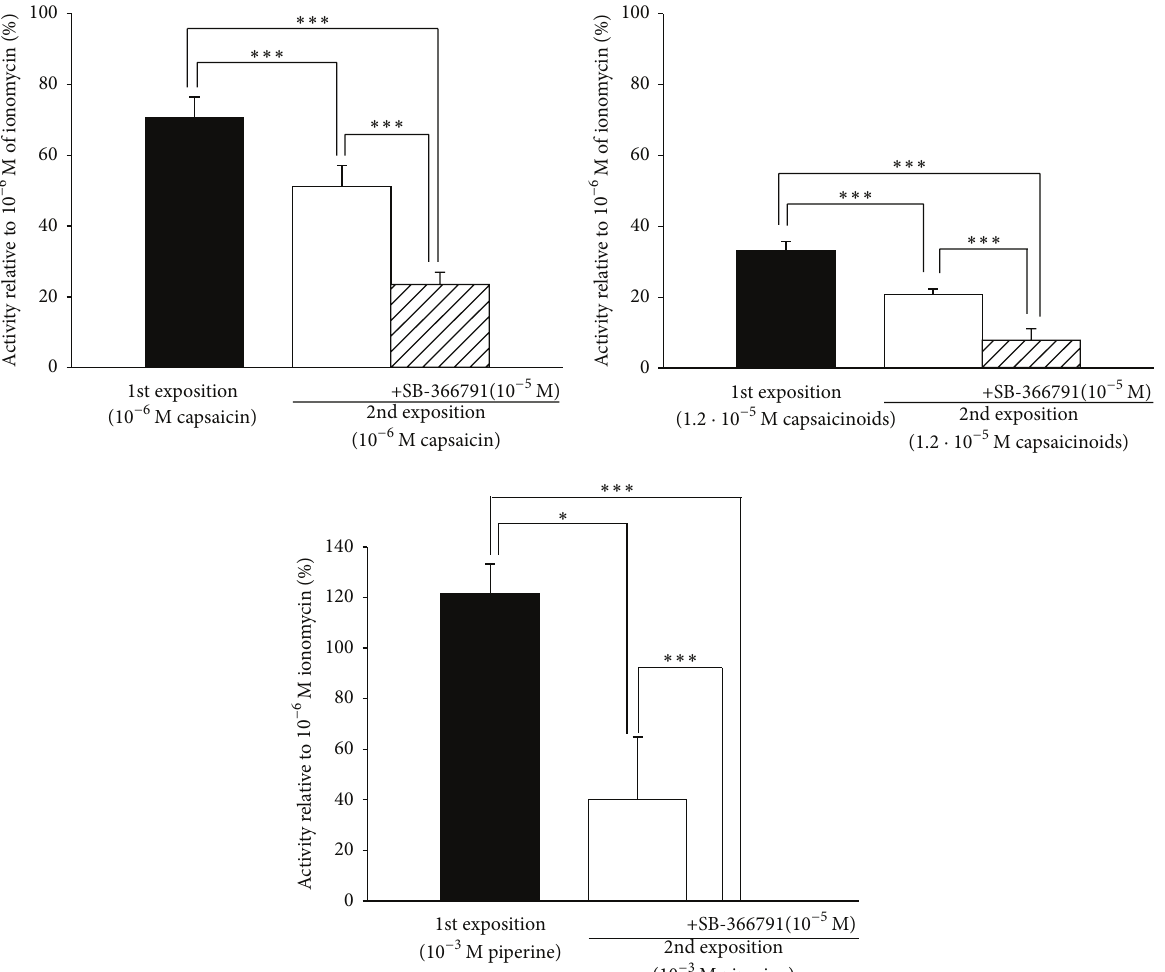
Figure 3: Desensitization and antagonist effect. Capsaicin, capsaicinoids, and piperine normalized first exposition effect (black box) is compared with their normalized second exposition effect (white box) and SB-366791 incubation before second exposition effect (striped box). Data is expressed as mean ± SEM. ∗ 𝑃 < 0.05 , ∗∗∗ 𝑃 < 0.001